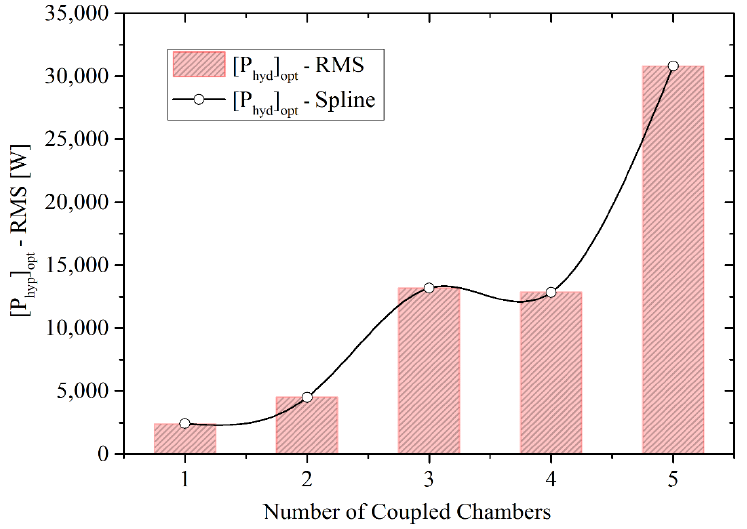
Figure 16. Available hydropneumatic power from the highest performing cases.